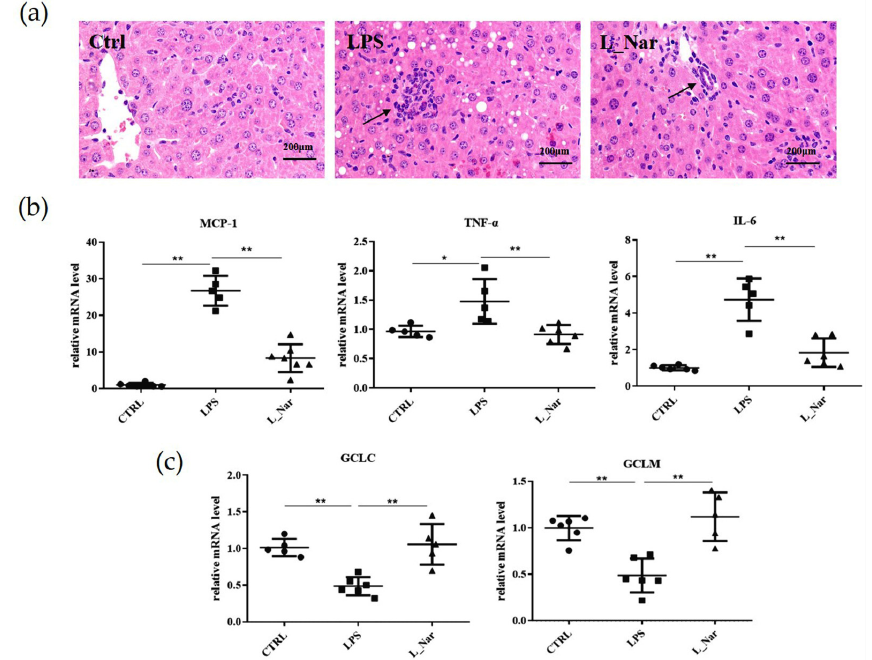
Figure 2. Effect of naringenin on inflammation and oxidative stress in the liver of mice: ( a ) H&E staining of liver sections (magnification, 20x), arrows indicate inflammatory infiltration; ( b ) expression of inflammatory factors MCP1, TNF α , IL-6; ( c ) antioxidant factors GCLC and GCLM mRNA levels. All values are mean ± SE ( n = 6). * p < 0.05, ** p < 0.01 versus CTRL group or LPS group; MCP1: mononuclear cell chemotactin-1; TNF α : tumor necrosis factor- α ; IL-6: interleukin 6; GCLC: glutamate-cysteine ligase catalytic subunit; GCLM: glutamate-cysteine ligase modifier subunit.